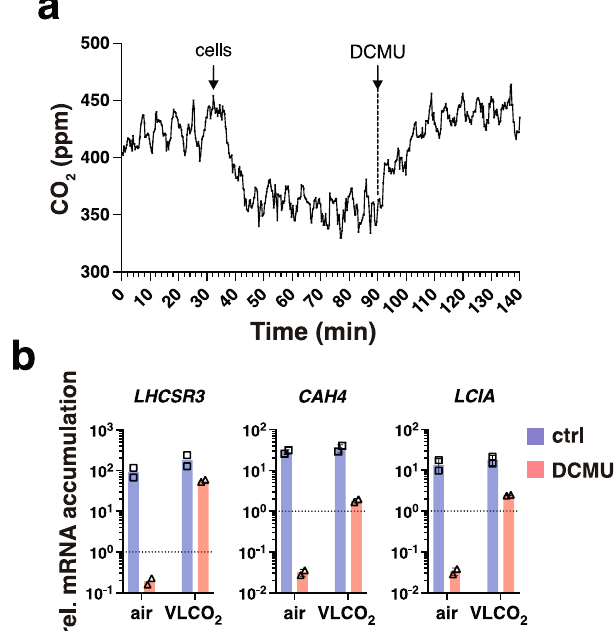
Fig. 6 | Photosynthetic electron transfer draws down the intracellular CO 2 concentration, relieving inhibition of LHCSR3 transcription. a CO 2 concentra- tionmeasuredintheairstreamcomingoutoftheheadspaceofacolumn fi lledwith 50mLofHSM,spargedwithairunderHL.Thetwoarrowsinthegraphindicatethe additionofcellsorDCMU. b WTcellswereacclimatedtoLLHSMovernightshaken in fl asks; the next day they were exposed to 300 µ mol photons m − 2 s − 1 light in the presenceorabsenceof40 µ MDCMU,shakenin fl askswithoutorwithspargingwith VLCO 2 .Samplesweretakenafter1h.PresentedaremRNAaccumulationof LHCSR3 , CAH4 , LCIA . Data were normalized to LL (shown as dotted line in graph); n =2 biological